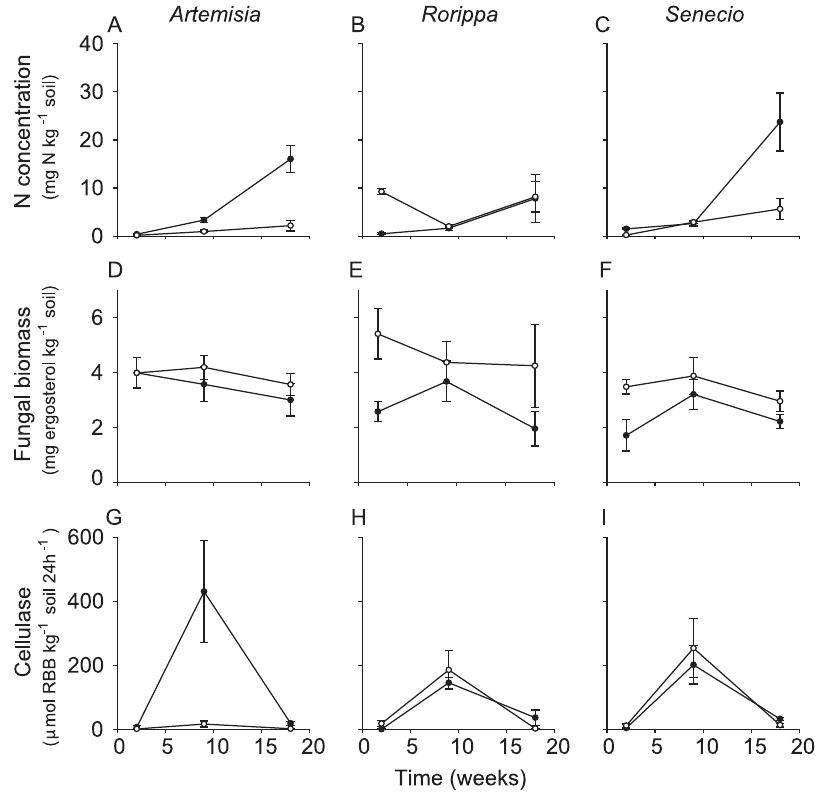
Figure 2. Effects of litter on nitrogen, fungal biomass and cellulase activity. Soil available inorganic nitrogen (N) (A, B, C), fungal biomass (D, E, F) and cellulase activity (G, H, I) in soil mixed with litter from exotic plant species (filled circles) and litter from native plant species (open circles). Means ( 6 SE) are presented for Artemisia (A, D, G), Rorippa (B, E, H) and Senecio (C, F, I).